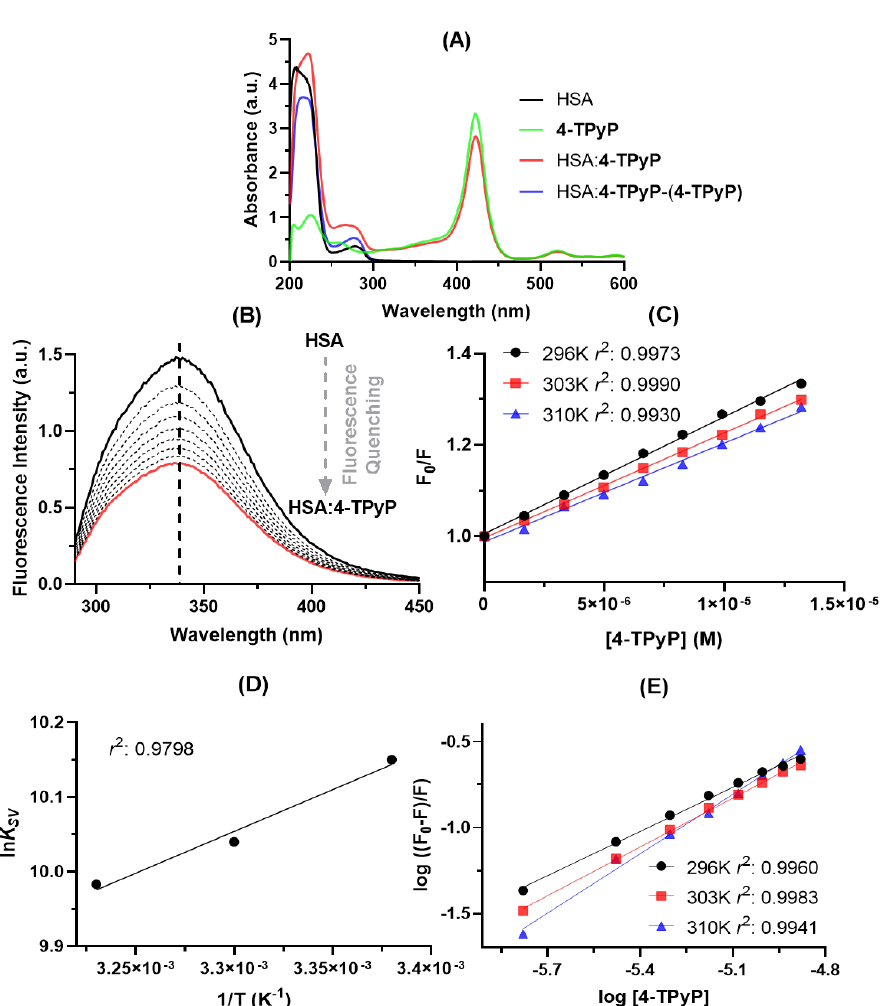
Figure 2. ( A ) UV-vis spectra for HSA (black line, 1.0 × 10 − 5 M), 4-TPyP (green line, 1.32 × 10 − 5 M), HSA:4-TPyP (red line), and mathematical subtraction (HSA:4-TPyP) – (4-TPyP) (blue line) in PBS solution (pH = 7.4) at 310 K. ( B ) Steady-state fluorescence emission spectra for HSA without and upon successive additions of 4-TPyP at 310 K ( λ exc = 280 nm). ( C ) Stern–Volmer plots for the interaction HSA:4-TPyP corresponding to the steady-state fluorescence data at three different temperatures. ( D ) Van’t Hoff plot based on K SV values for HSA:4-TPyP. ( E ) Double logarithmic plots for the interaction HSA:4-TPyP at three different temperatures. The r 2 in each plot is the coefficient of determination. [HSA] = 1.0 × 10 − 5 M and [4-TPyP] = 0.17, 0.33, 0.50, 0.66, 0.83, 0.99, 1.15, and 1.32 × 10 − 5 M. Table 1. Binding parameters for the interaction HSA:4-TPyP in PBS (pH = 7.4) at three different temperatures.